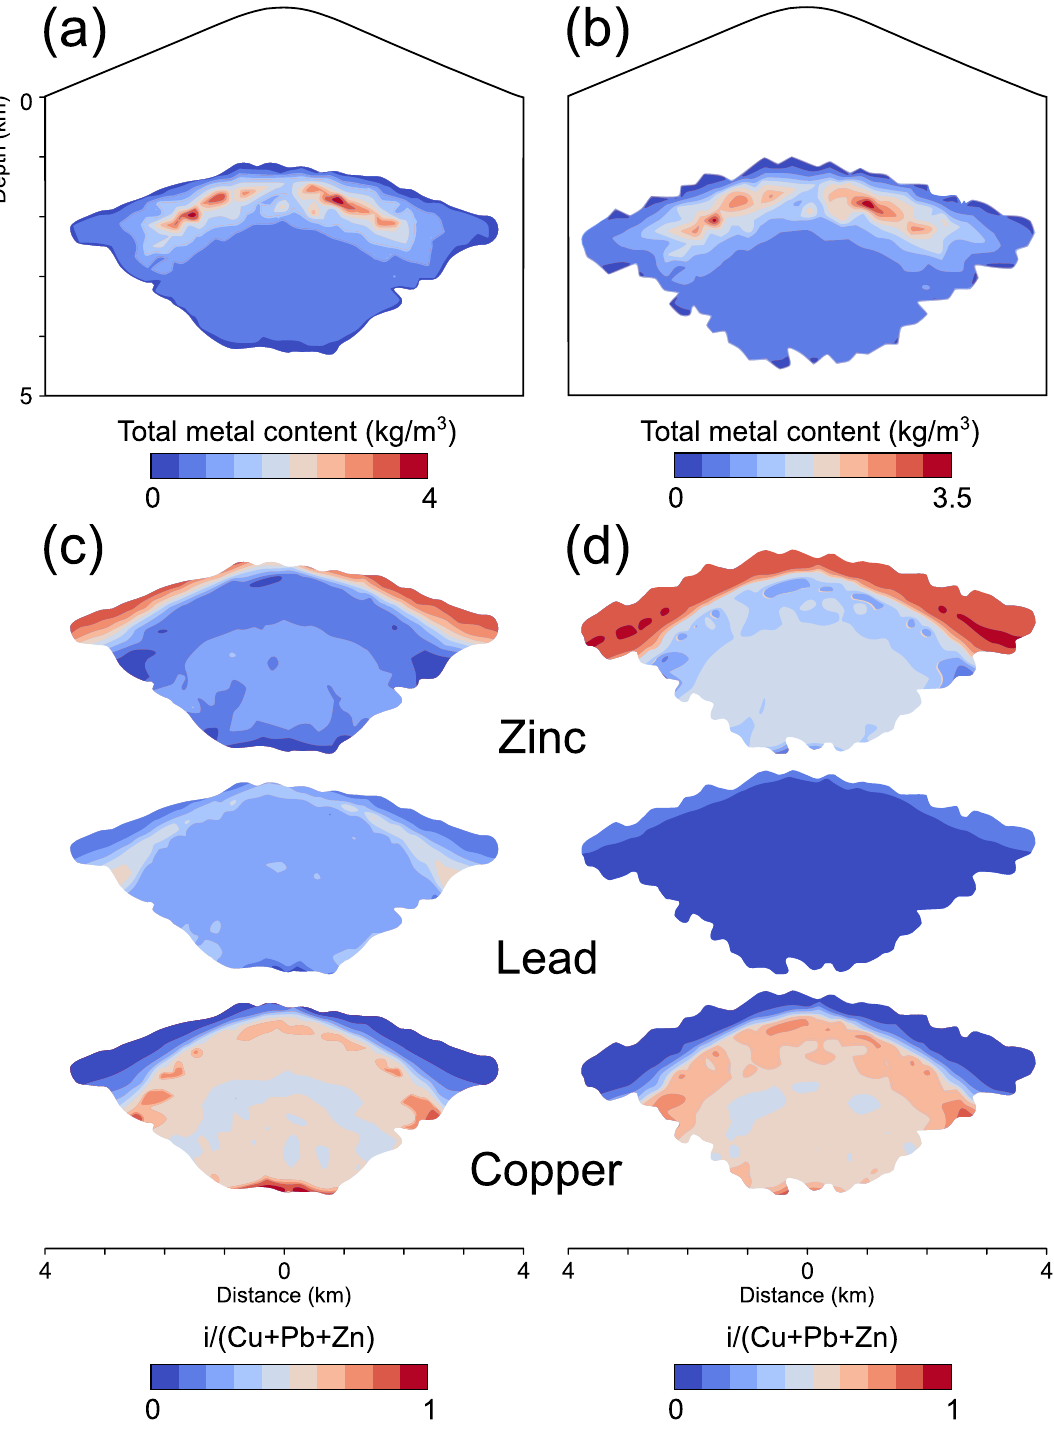
Figure 5. Total modeled metal content of the rock after 100 kyrs of simulation time above a threshold of 0.5 kg/ m 3 (sum of the copper, lead and zinc contents) for the simulations 1 ( a ) and 3 ( b ). Individual metal fractions within these areas of enrichment illustrate the modeled base metal zonation ( c , d